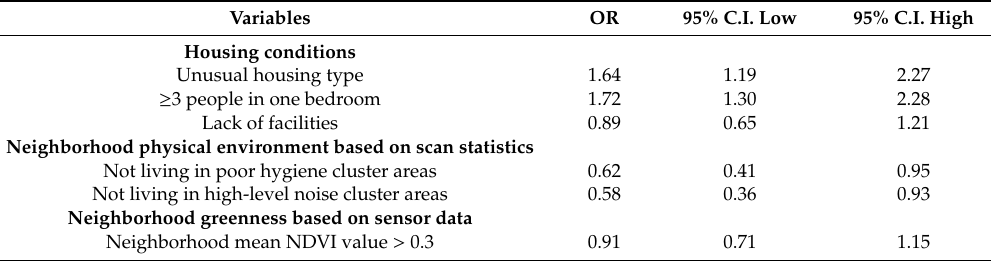
Table 5. Fully adjusted odds ratios (ORs) of housing conditions and neighborhood physical environments on SHS exposure at home among non-smoking migrant workers with poor neighborhood physical environments excluded. C.I.: confidence interval. NDVI: Normalized Di ff erence Vegetation Index.